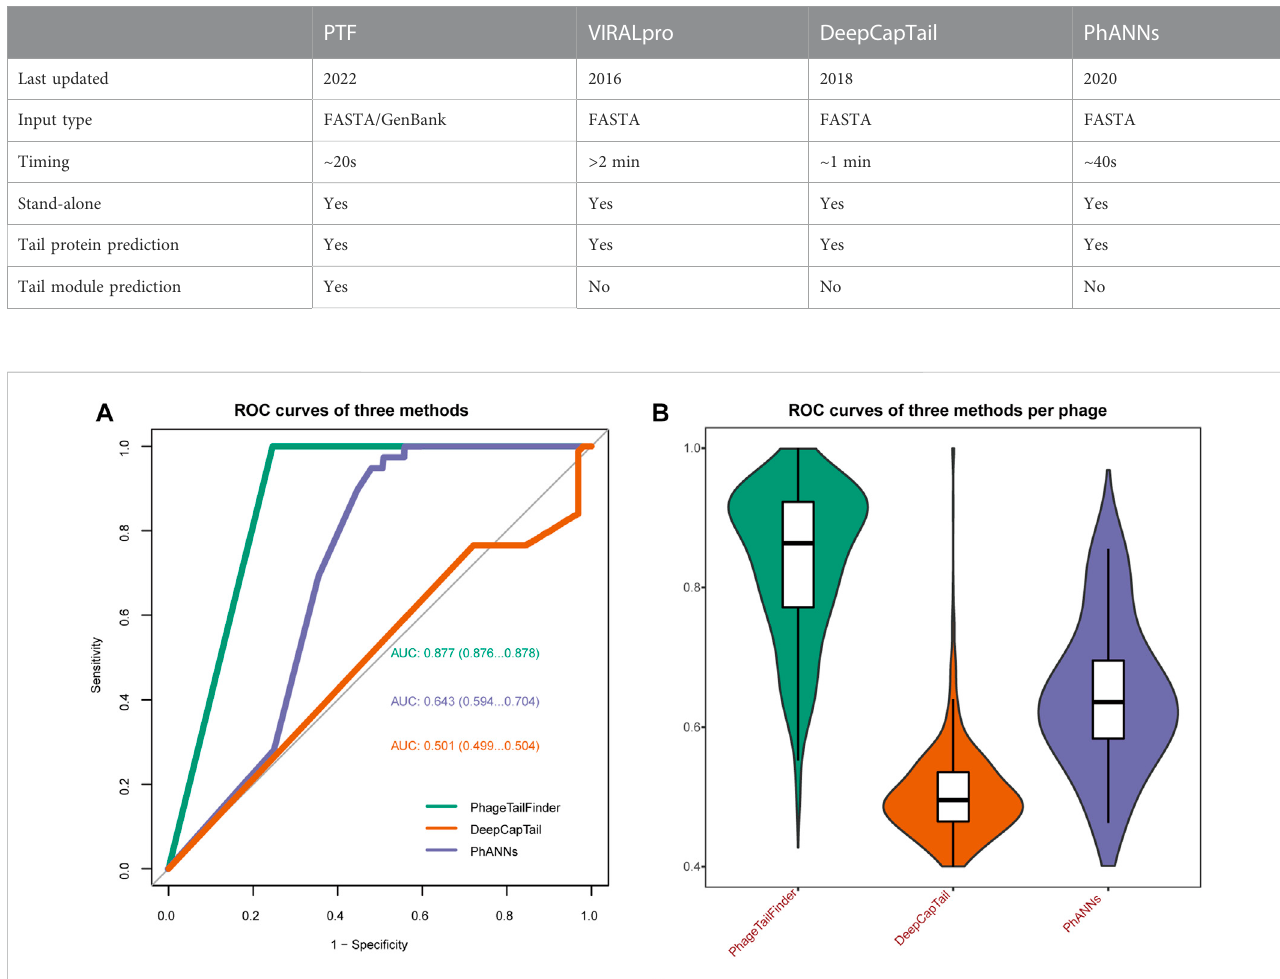
TABLE 4 Comparison of the PhageTailFinder (PTF) with other prediction tools.